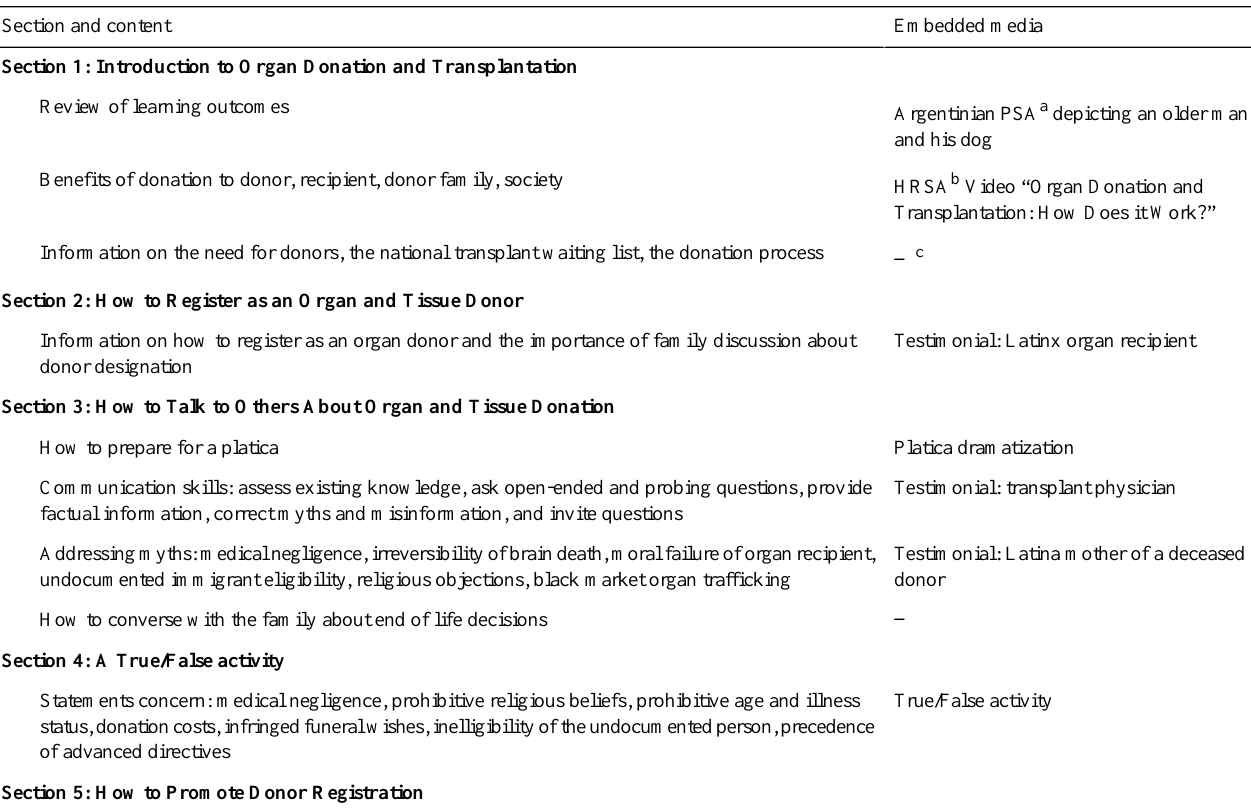
Table 1. Promotoras de Donación module